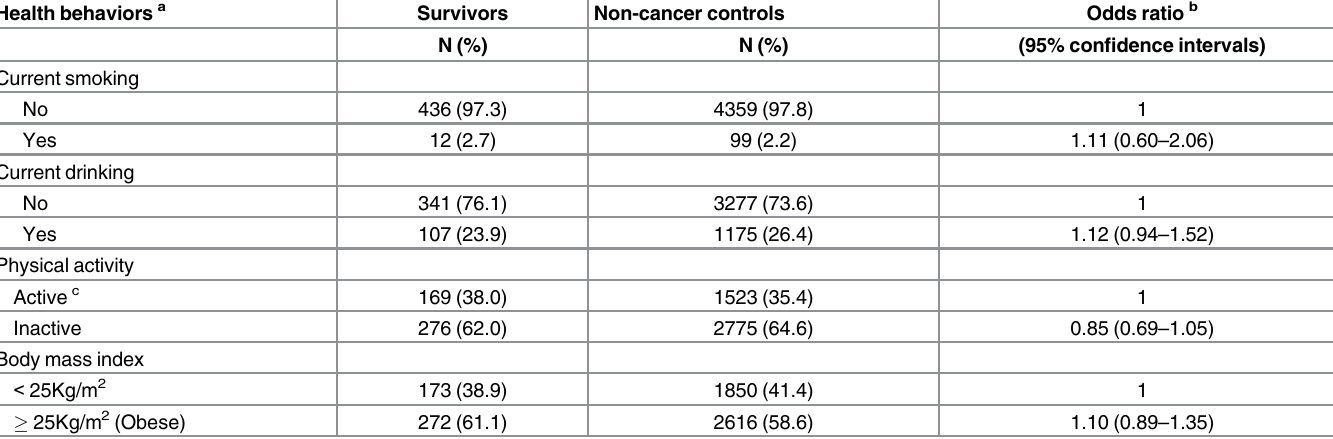
Table 2. Health behaviors in cervical cancer survivors compared with female respondents never diagnosed as having cancer.